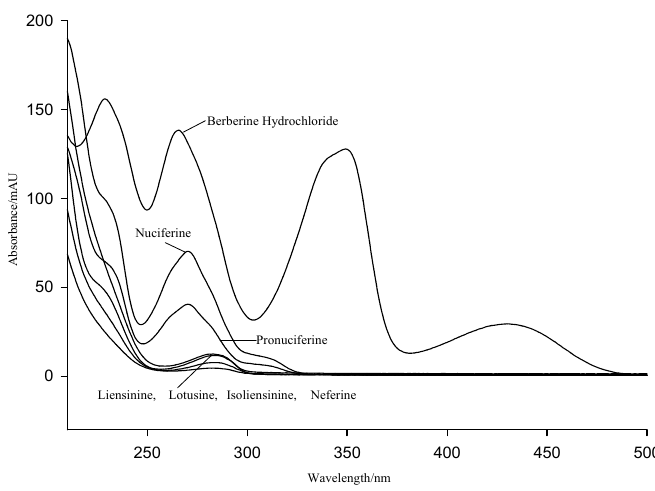
Figure 1. Absorbance of seven kinds of alkaloids.